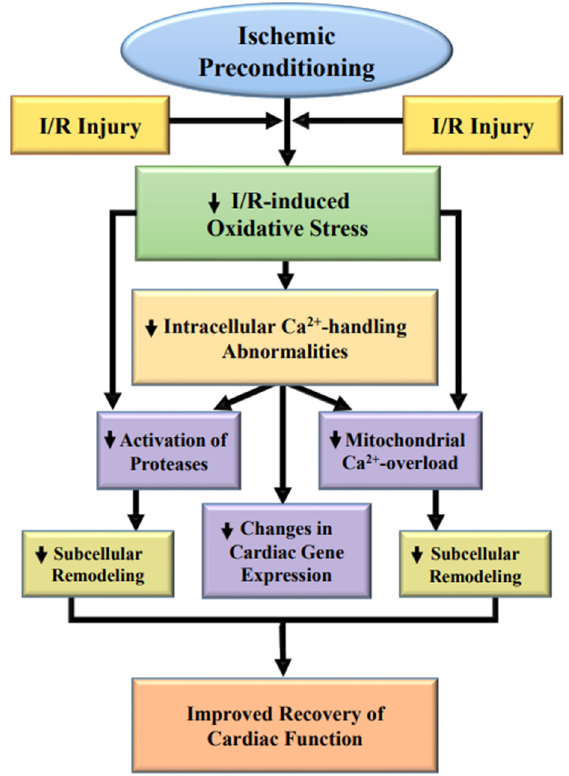
Figure 3. Proposed cardioprotective mechanisms of ischemic preconditioning for improving cardiac function in hearts subjected to ischemia/reperfusion (I/R) injury.